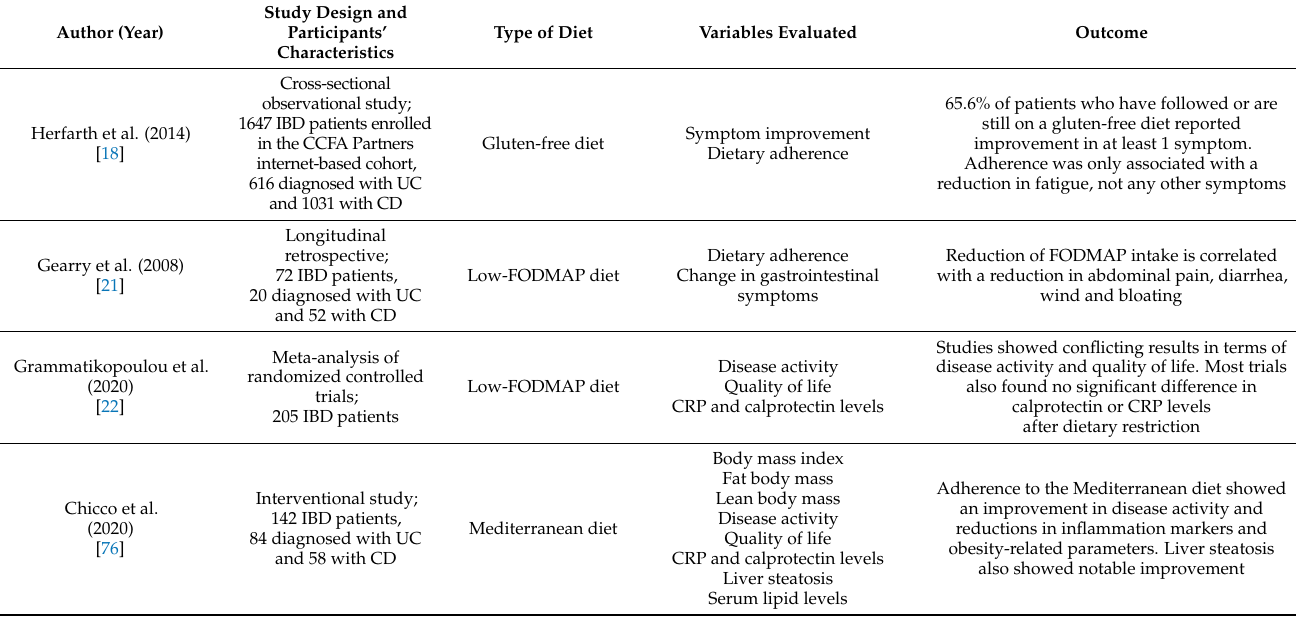
Table 3. Studies analysing the impact of different diets in patients with